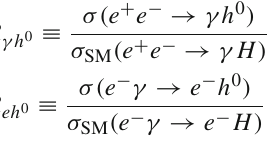
Fig. 2 Generic Feynman diagrams for h 0 → γ V ( V = γ or Z ) process in the HTM . F denote any fermion and S stand for H ± and H